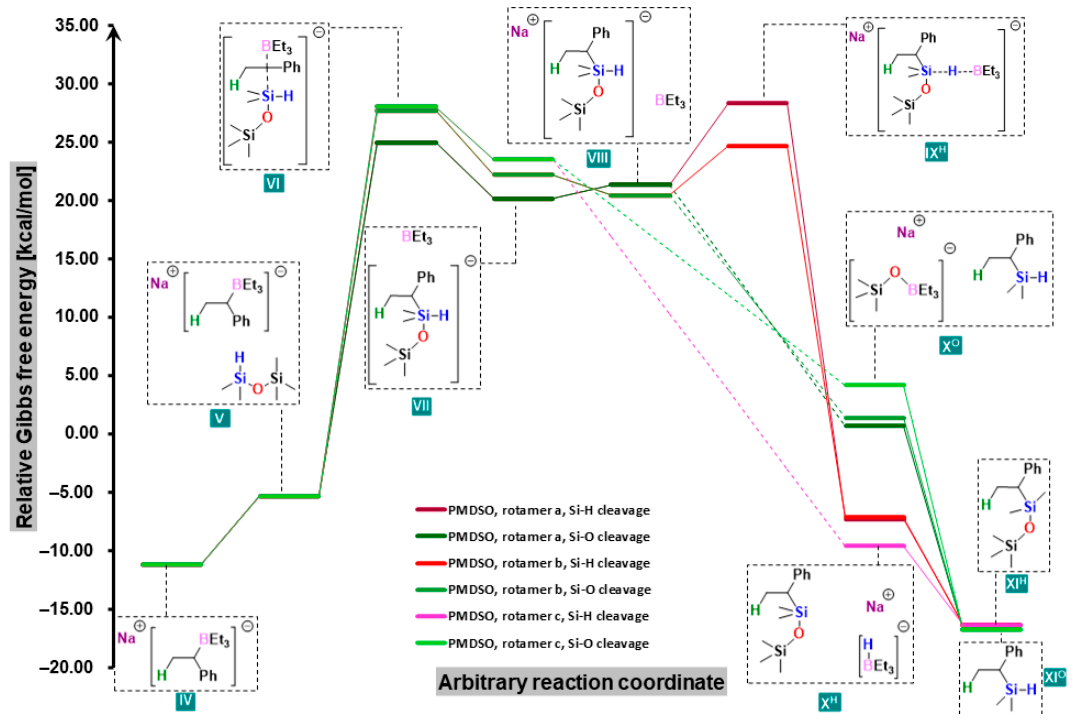
Figure 3. Free-energy profiles for two possible pathways of the reaction of styrene with PMDSO in the presence of sodium trialkylborohydride.